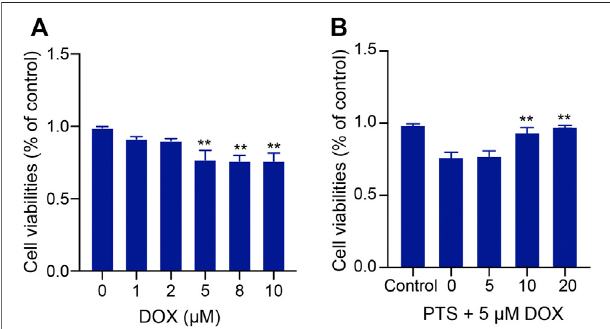
FIGURE 3 | Effect of PTS treatment on cell viability in DOX-treated HepG2 cells. (A) . Effects of different DOX dose (0, 1, 2, 5, 8, 10 μ M) - induced hepatotoxicity on HepG2cells ( n =3); (B) PTSeffects(0, 5,10,and 20 μ M) on DOX-induced HepG2 cell viability ( n = 3). ** p < 0.01 versus control